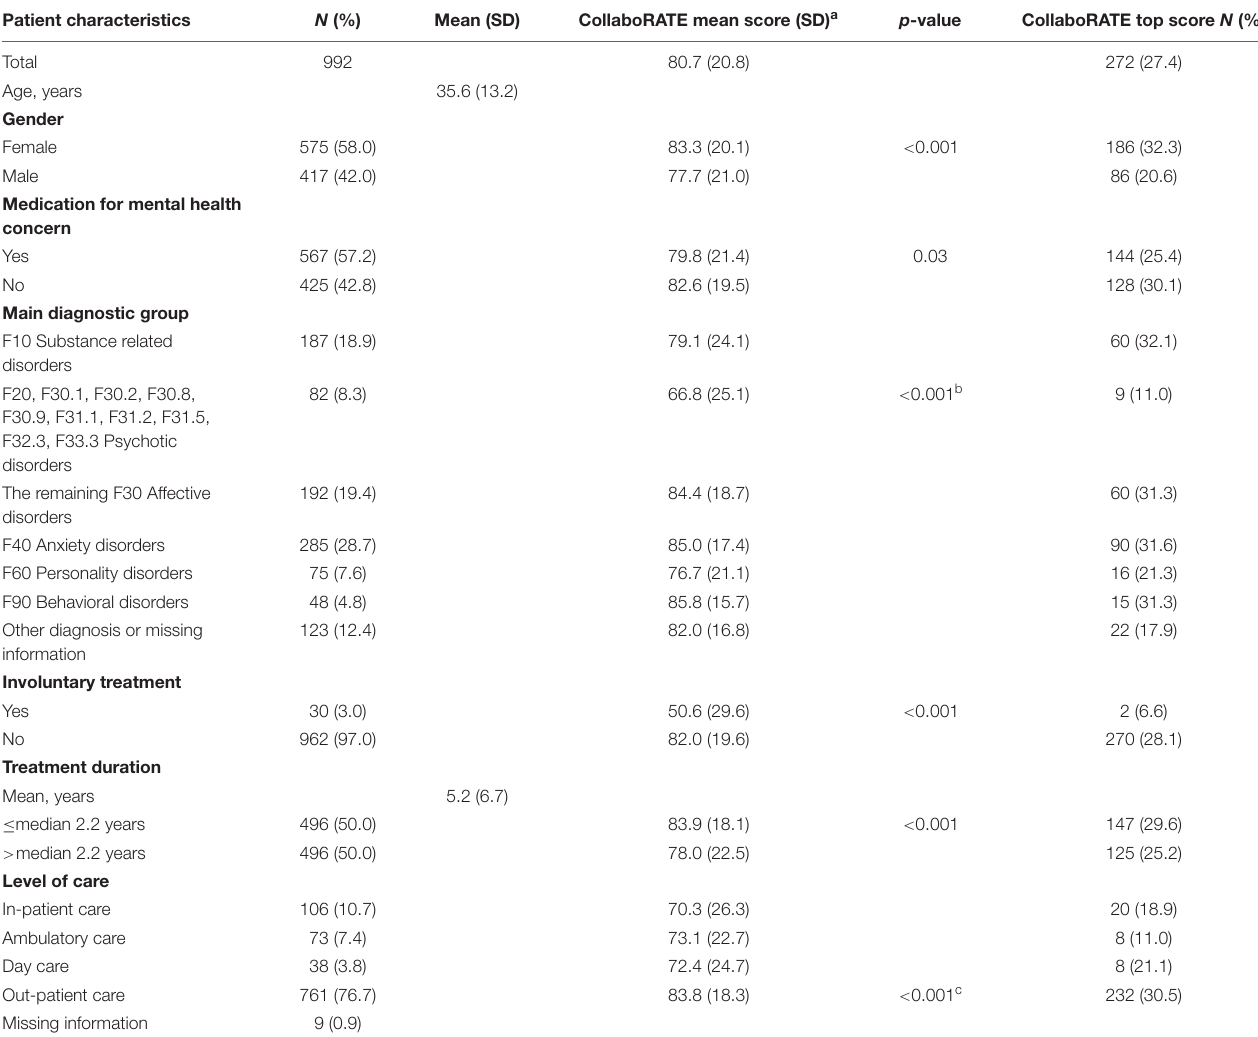
TABLE 1 | Characteristics of the patients, CollaboRATE mean scores and proportion top scores for the different subgroups of patients, and statistical significance of differences between the subgroups, n = 992. Patient